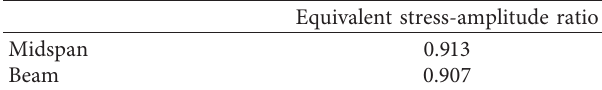
Figure 16: Effect of the wheel transverse position on the stress amplitude of the bridge deck. Table 5: Equivalent stress-amplitude